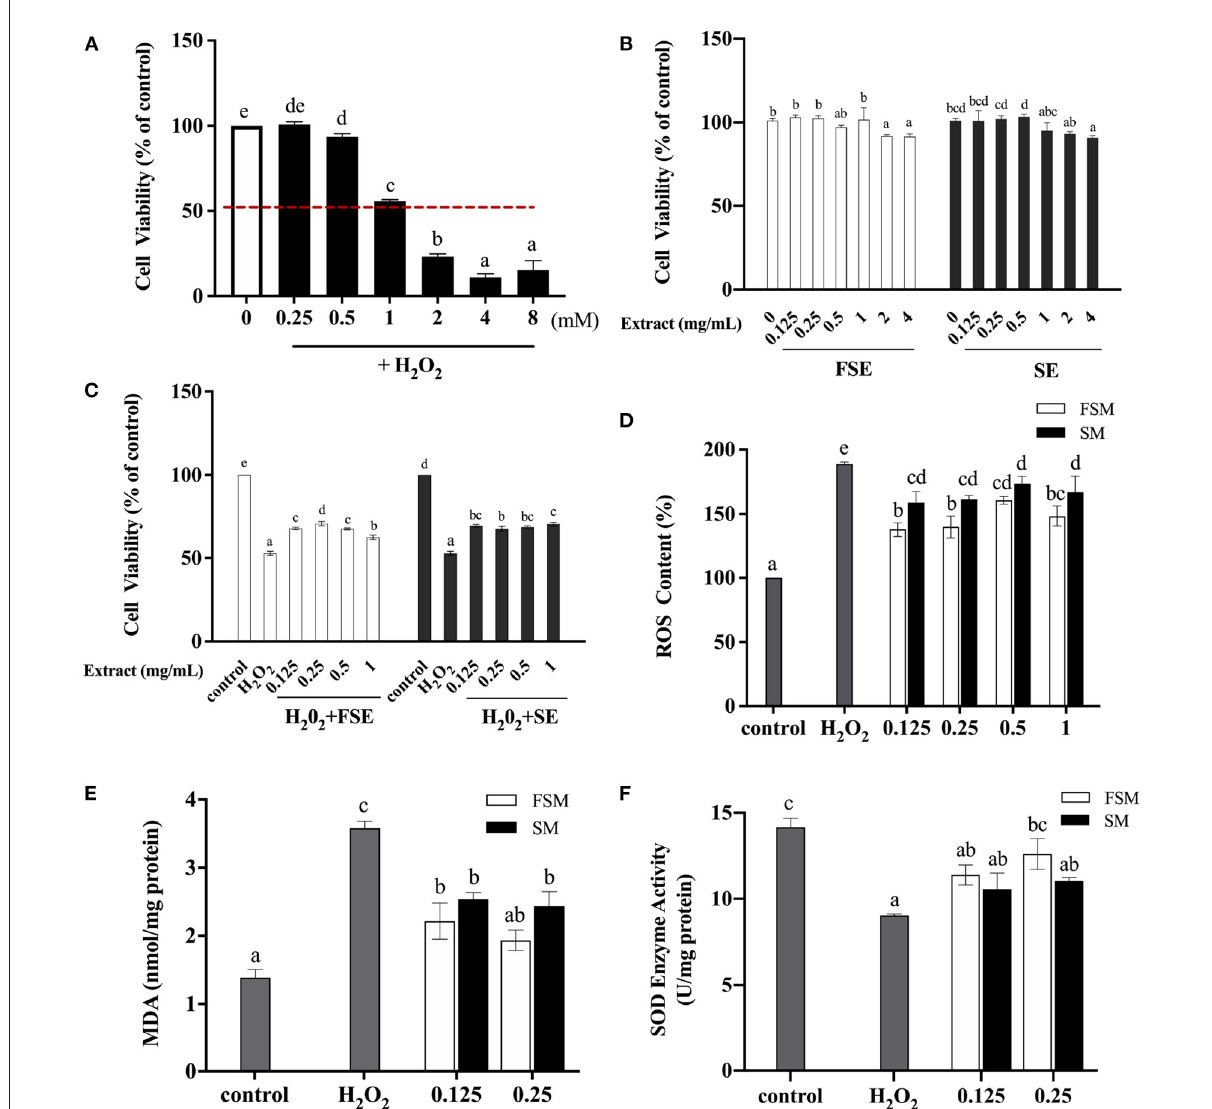
FIGURE5 Protective effect of fermented soymilk on H 2 O 2 -induced oxidative damage in Caco-2 cells. (A) Effect of different concentrations of H 2 O 2 on the activity of Caco-2 cells; (B) Effects of different concentrations of FSE and SE on the activity of Caco-2 cells; (C) Effects of different concentrations of FSE and SE on the activity of H 2 O 2 -induced Caco-2 cells; (D) Effects of FSE and SE on the content of reactive oxygen species (ROS) in H 2 O 2 -stimulated Caco-2 cells; (E) Effects of FSE and SE on the content of malondialdehyde (MDA) in H 2 O 2 -stimulated Caco-2 cells;